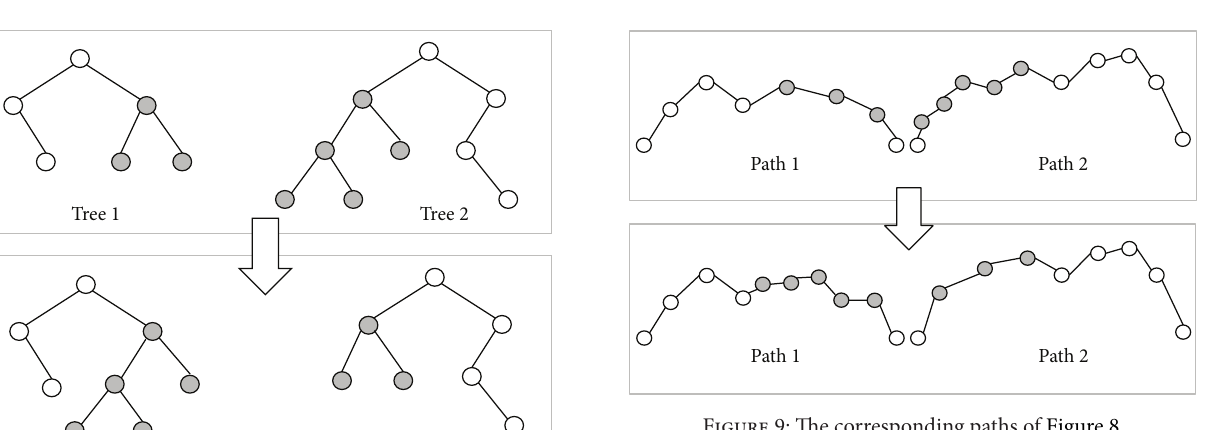
Figure 9: The corresponding paths of Figure 8.